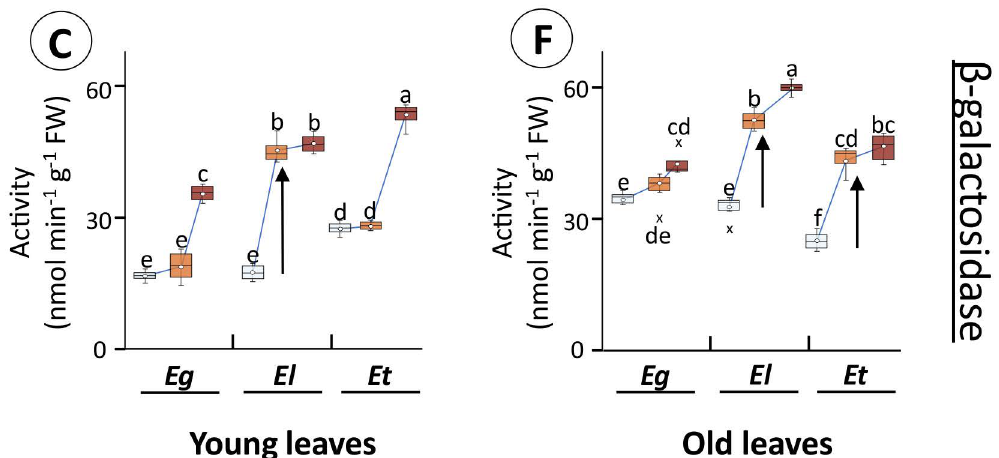
Figure 7. Activities of hydrolases in Eucalyptus leaf extracts in dependence on salt exposure. Activities of phosphatase ( A , D ), phosphodiesterase ( B , E ), and β -galactosidase ( C , F ) were measured in young and old leaves of 30 d salt (80 or 170 mM NaCl)-treated Eucalyptus spp. Different letters indicate significance of difference after statistical analysis of the means ( n = 4, p < 0.05; ANOVA and Tukey’s post-hoc test). (In box plots: hollow circle = mean, the horizontal line in the box = median, box limits = 25th, 75th percentiles, whiskers extend 1.5 times the interquartile range from the 25th and 75th percentiles, not connected data points; cross =